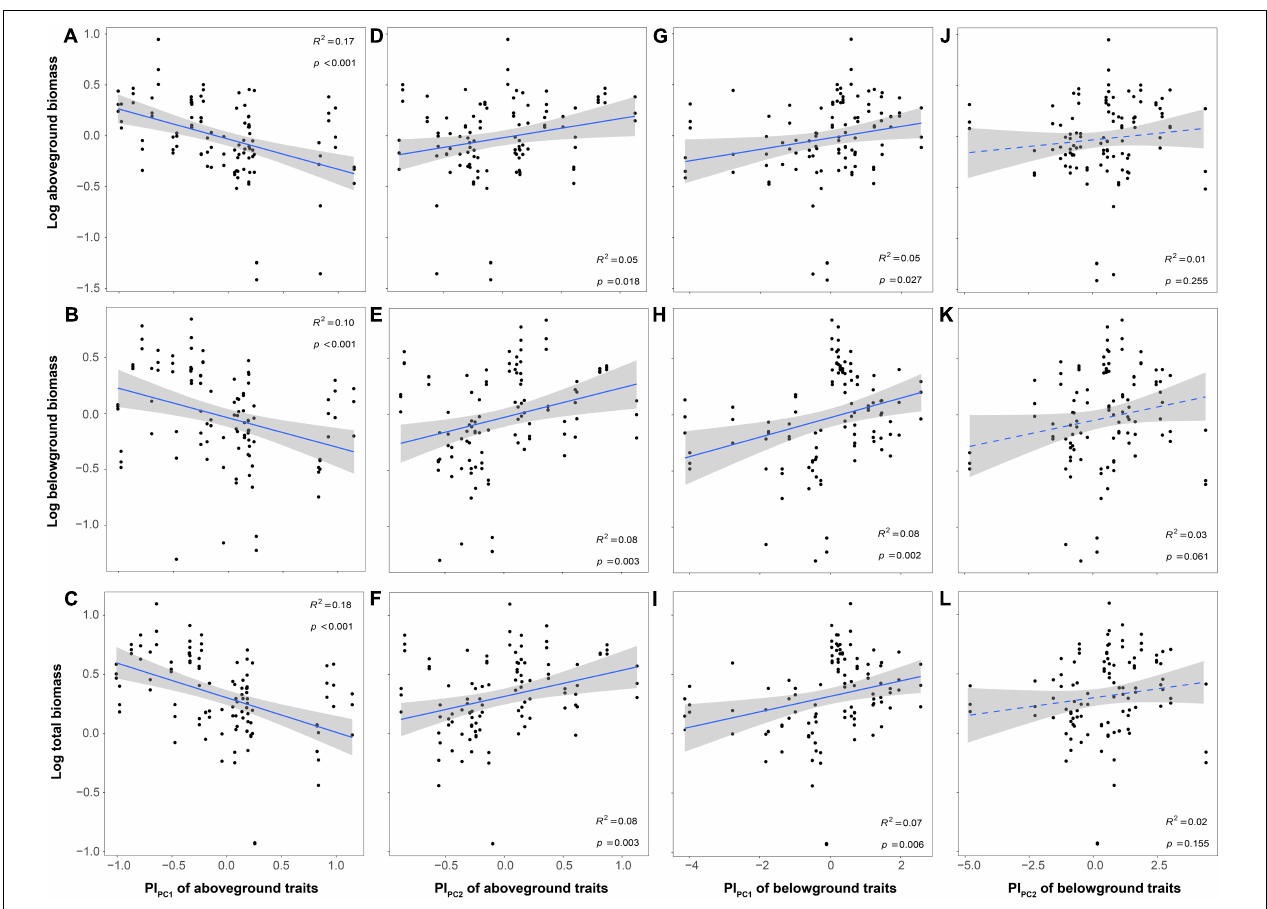
FIGURE 5 | Relationships between plant biomass and trait plasticity [ (A–F) , for PI PC of aboveground and (G–L) for PI PC of belowground]. The R 2 (coefficient of determination) and p -values are obtained from the linear regression analyses. Shaded areas show 95% confidence interval of the fit